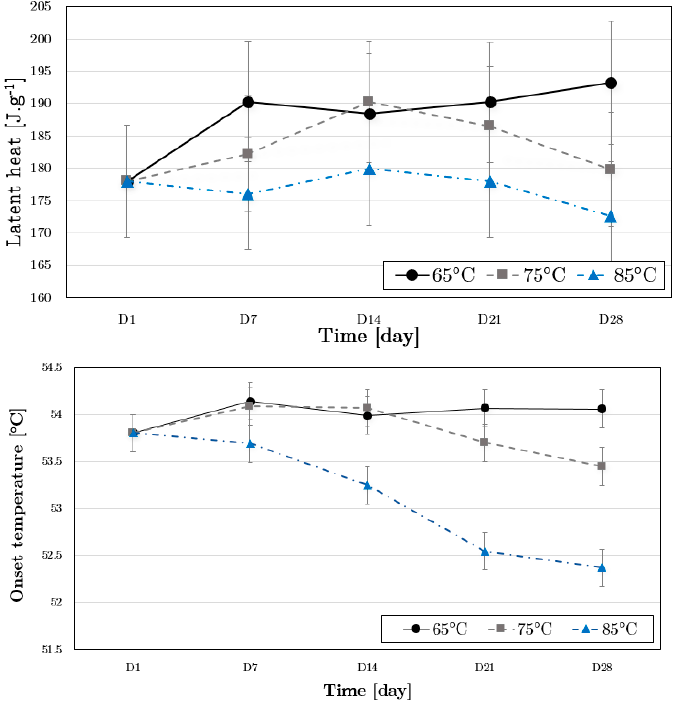
Figure 2. SA–PA mixture properties’ evolution over constant temperature exposure: latent heat of fusion (top) and onset temperature (bottom).